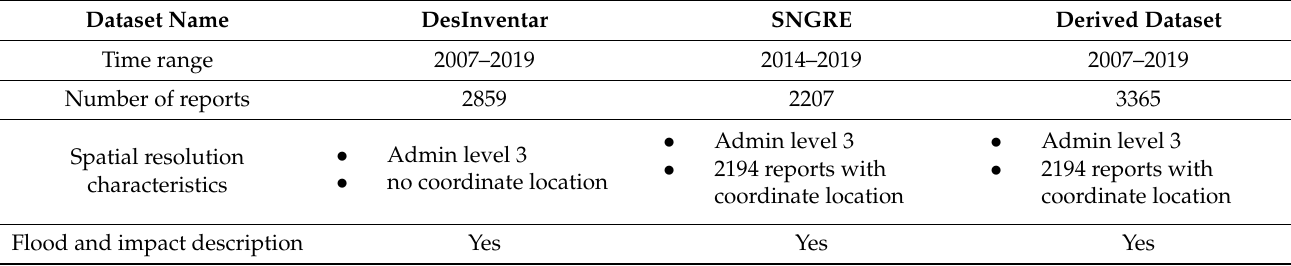
Table 3. Attributes of historical flood datasets in Ecuador and for the derived dataset. Dataset